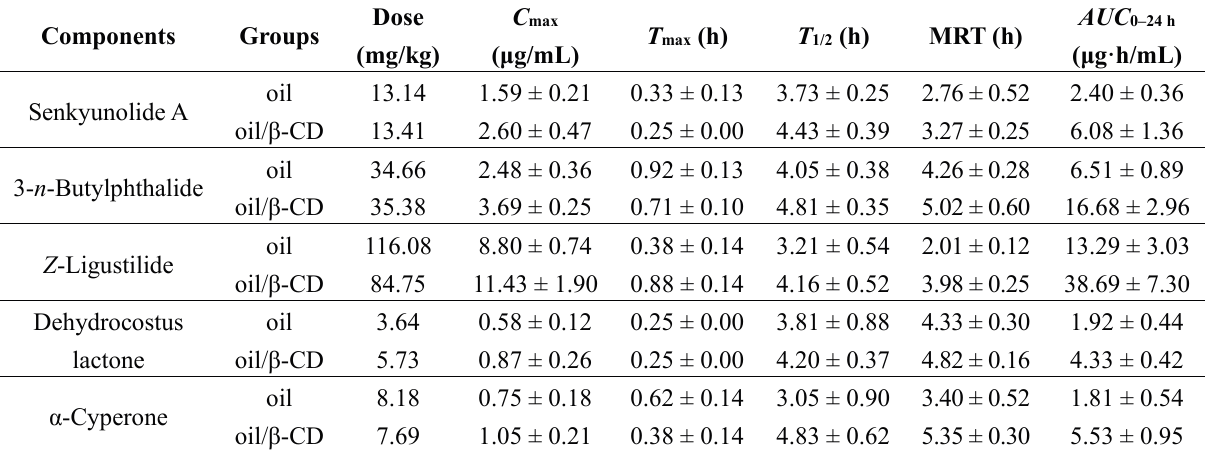
Table 1. Summary of pharmacokinetic parameters ( n =